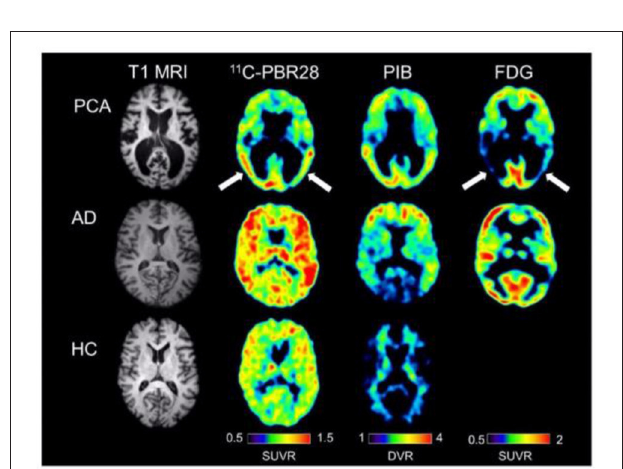
FIGURE 5 | Single subject images from a patient with posterior cortical atrophy (top row), a patient with amnestic Alzheimer’s disease (center row), and a healthy control subject (bottom row). The posterior cortical atrophy subject showed focal occipito-temporal [ 11 C]PBR28 binding, with FDG hypometabolism in the same region (arrows). While the posterior cortical atrophy subjects showed occipito-temporal PIB binding, PIB binding was also found in frontal cortex. The subject with amnestic Alzheimer’s disease showed more diffuse [ 11 C]PBR28 binding, with occipital sparing on PIB and classic bilateral temporo-parietal hypometabolism on FDG imaging. The control subject showed low amounts of diffuse [ 11 C]PBR28 binding and absence of cortical [ 11 C]PIB binding. Courtesy from Kreisl et al.